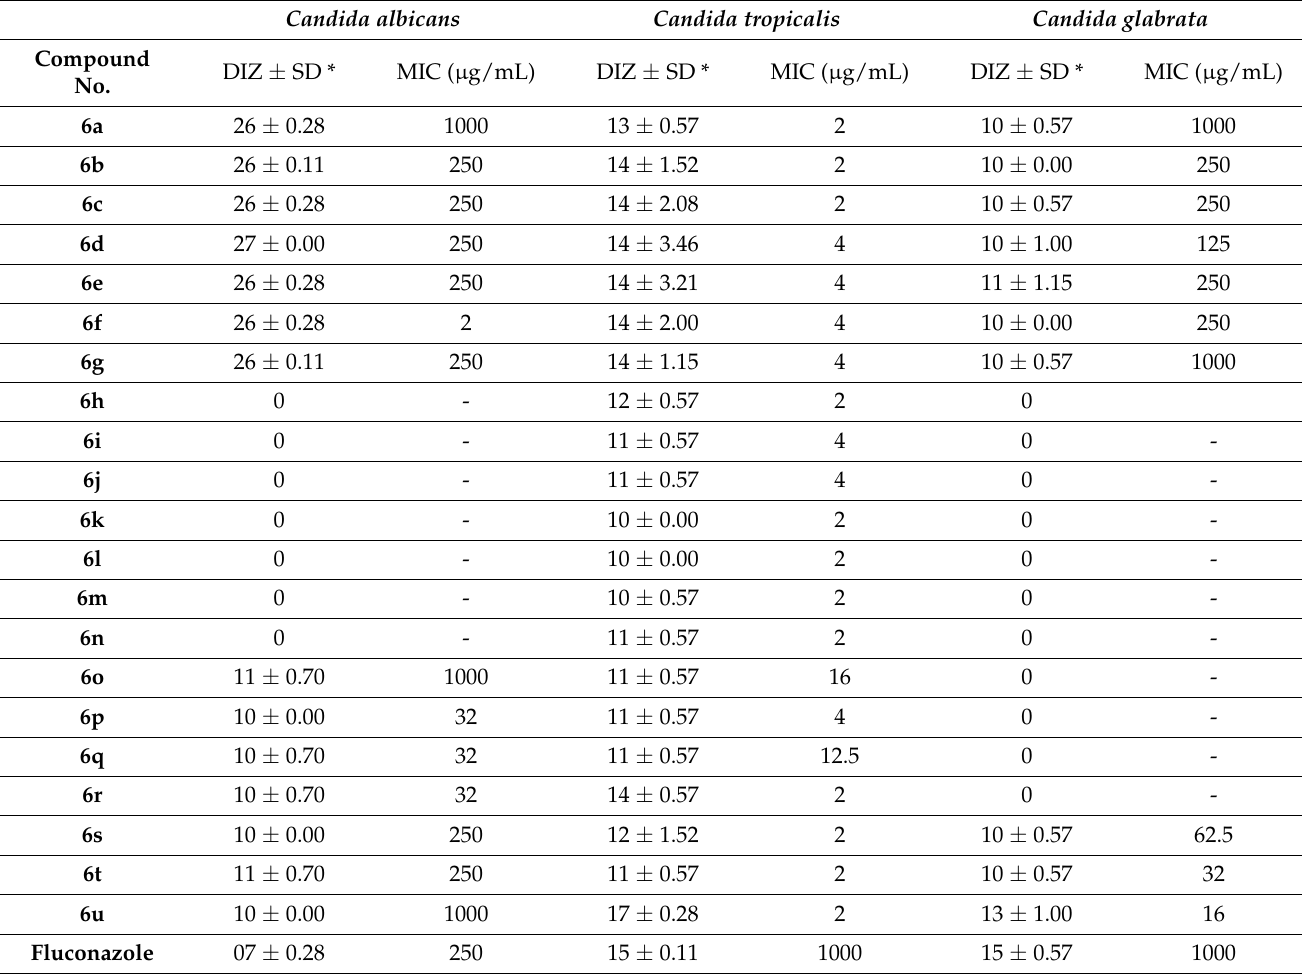
Table 2. Antifungal activity of the target compounds 6a-u against Candida albicans , Candida tropicalis, and Candida glabrata . Candida albicans Candida tropicalis Candida